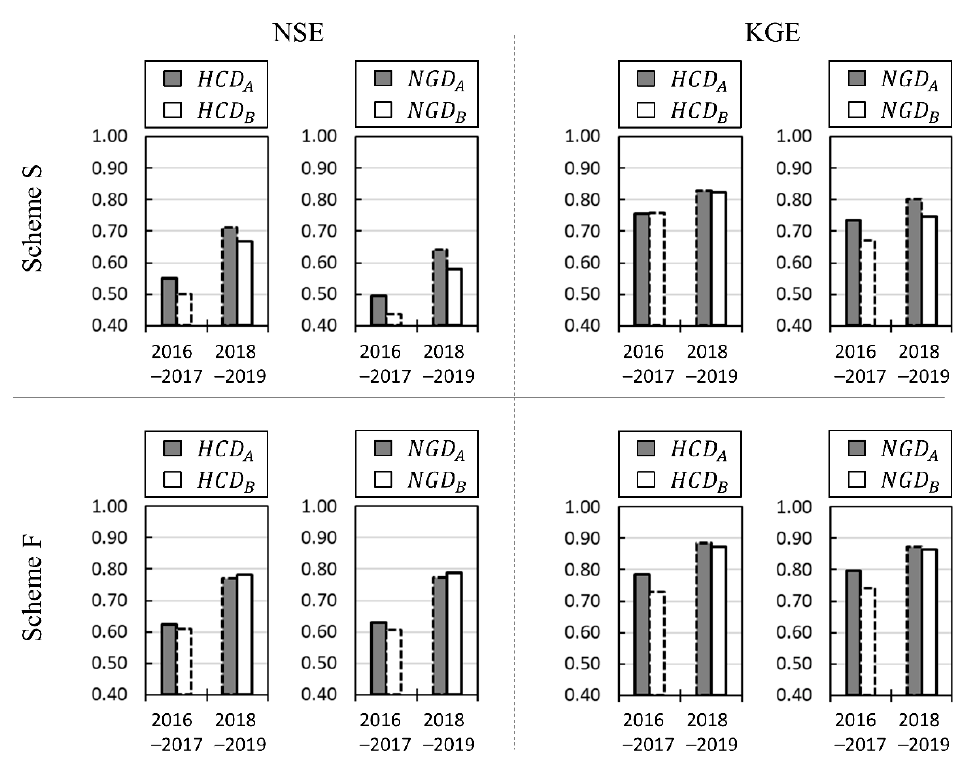
Figure 6. NSE and KGE between observed daily stream flow and simulated daily stream flow by calibration schemes S and F for 2016–2017 and 2018–2019. The solid line bars indicate results for calibration periods, and the dotted line bars indicate ones for validation periods.